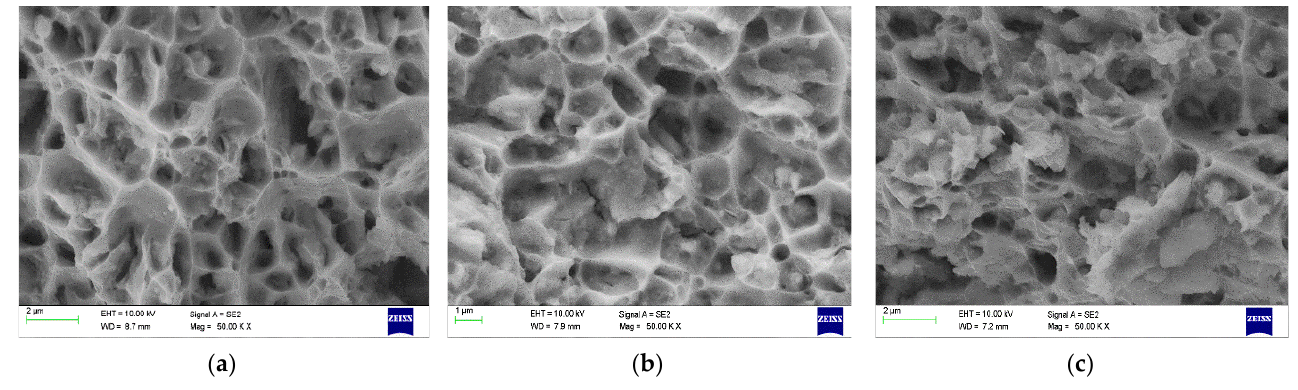
Figure 22. Fractography SEM image of 2024 ( a ) 1% Gr ( b ) 2%Gr ( c )